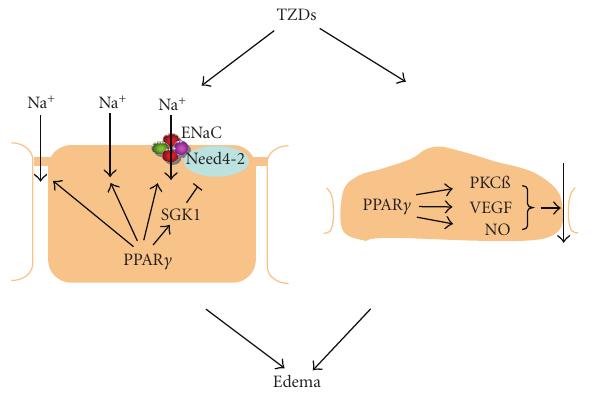
Figure 3: The mechanism for thiazolidinedione- (TZD-) induced edema. In the renal collecting duct, PPAR γ activation increases sodium reabsorption through ENaC-dependent and independent mechanisms. In the blood vessels of adipose tissues, PPAR γ ligands activate PKCß, VEGF, and NO, which together lead to increased endothelial permeability. The increased renal sodium retention at the level of the collecting duct in conjunction with increased vascular permeability may determine edema